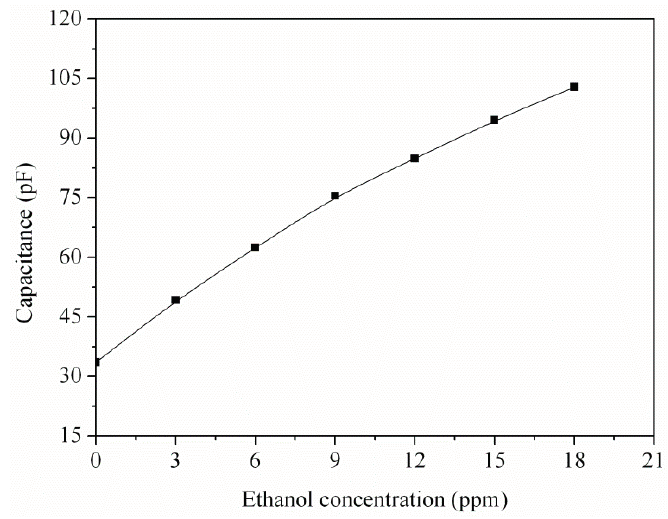
Figure 11. Capacitance variation of the ethanol sensor.